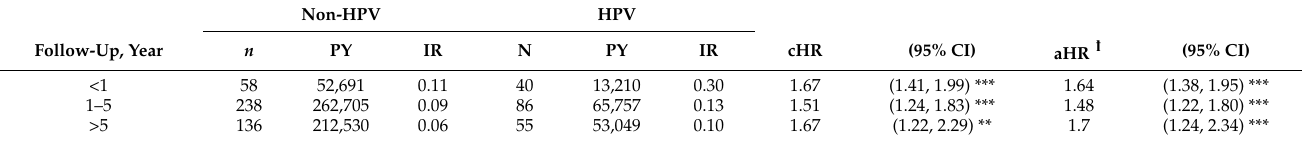
Table 5. Effect of HPV infection on ED development, stratified by follow-up duration to ED onset. Table 3. The association of explanatory variables and the risk of erectile dysfunction.